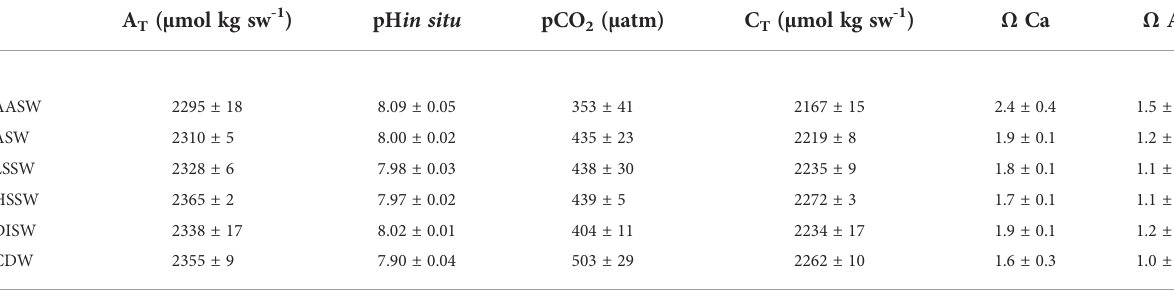
TABLE 2 Mean and standard deviation of values of carbonate system parameters in water masses.